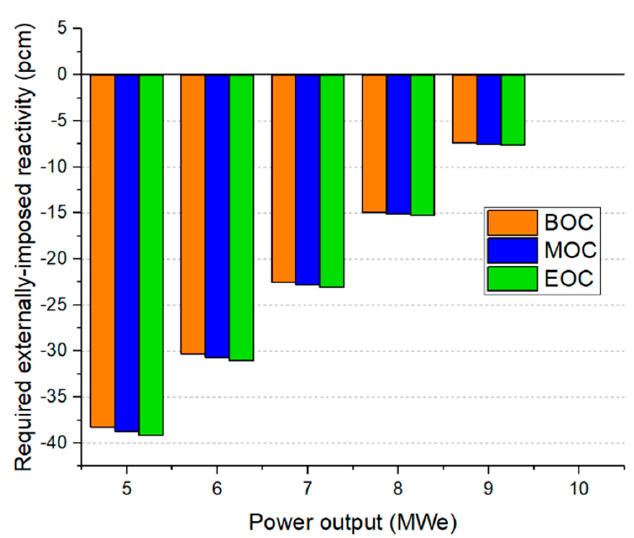
Figure 10. Externally-imposed reactivity required for different power output.